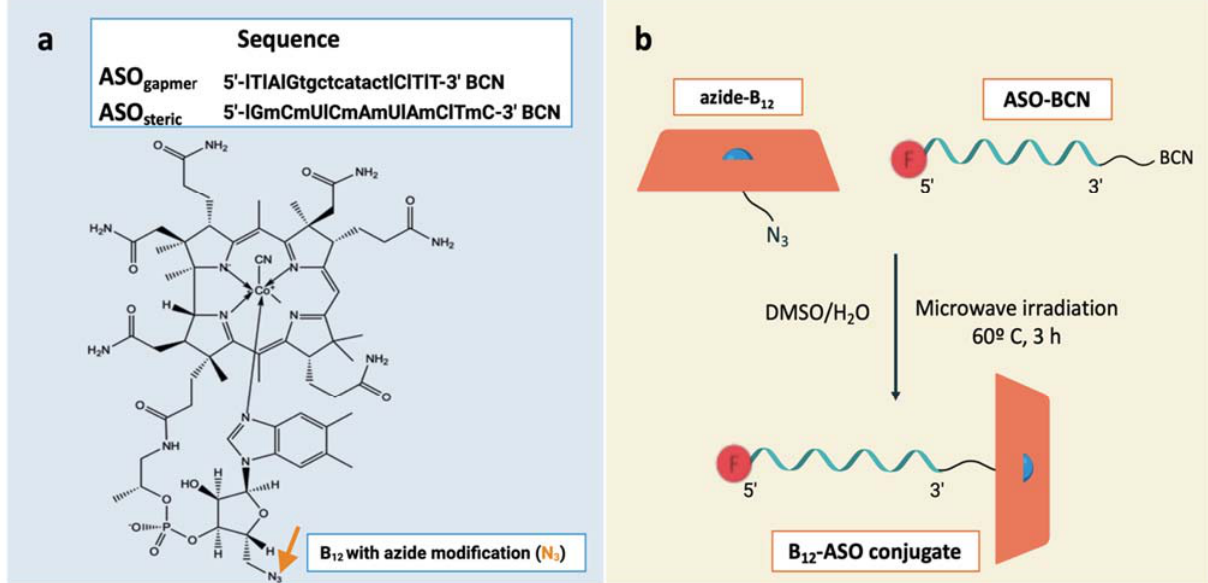
Figure 2. B 12 and antisense oligonucleotides (ASOs) conjugation: sequences and structures. ( a ) Sequence of the ASO gapmer and the ASO steric (LNA nucleotide monomers are represented with upper case letters preceded by l, 2 (cid:48) OMe monomers are represented with upper case letters preceded by m, and DNA monomers are represented by lower case letters) and structure of 5 (cid:48) -end azide-modified B 12 used in this study. The arrow points to the region of conjugation. ( b ) Schematic illustration of the synthesis of the B 12 -ASO conjugates through copper-free azide-alkyne